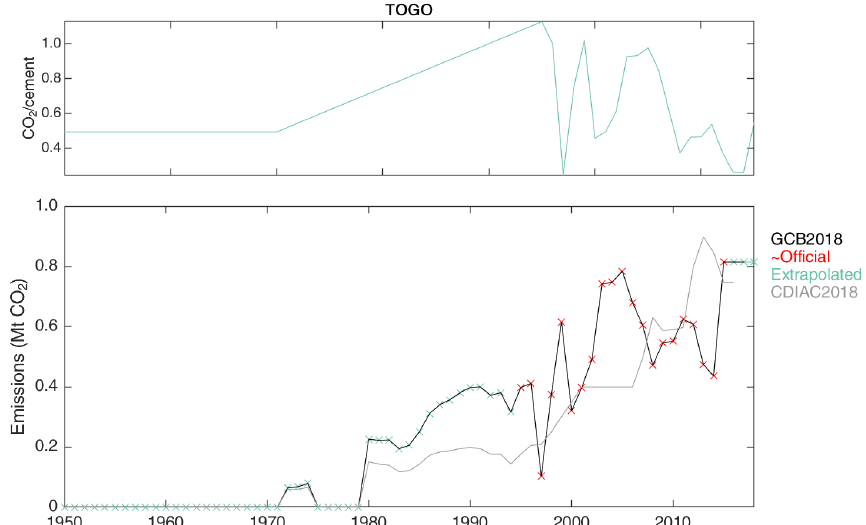
Figure C41. Revised cement emissions in